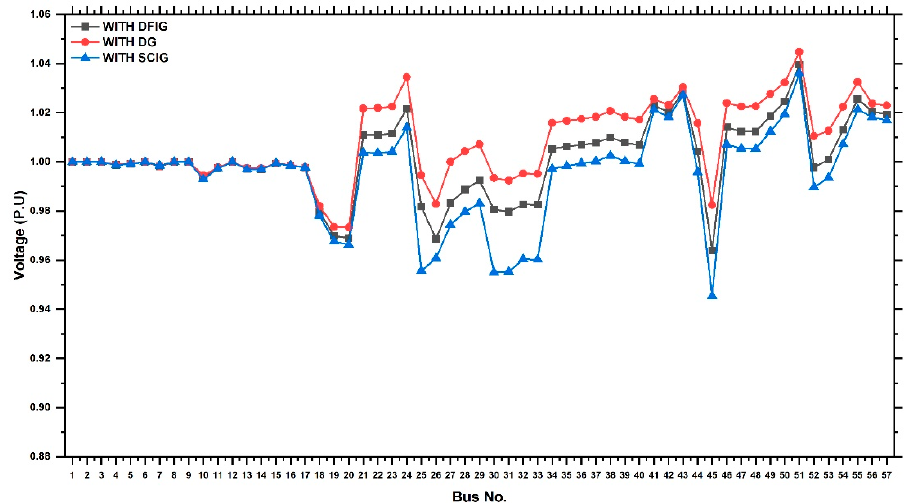
Figure 12. Comparison of voltage profile of a DFIG, a SCIG and a diesel generator.